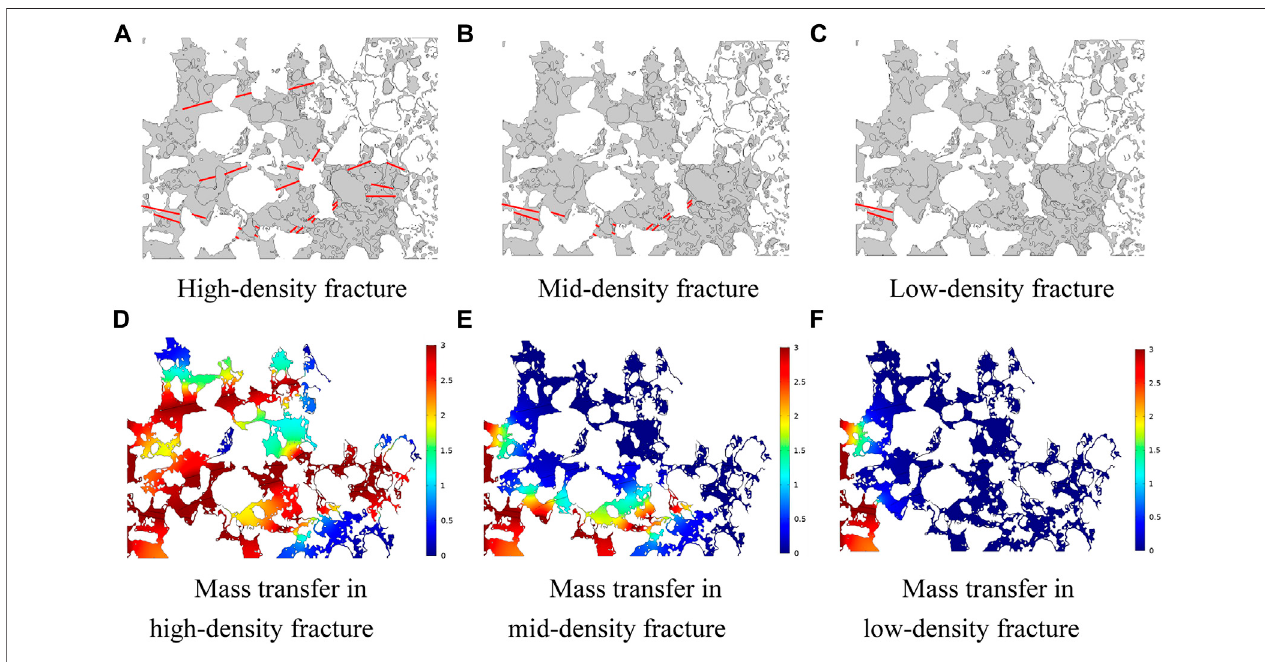
FIGURE 12 | Comparison of mass transfer at 1ms with different fracture density. (A) High-density fracture, (B) mid-density fracture, (C ) low-density fracture, (D) mass transfer in the high-density fracture, (E) mass transfer in the mid-density fracture, and (F) mass transfer in the low-density fracture.